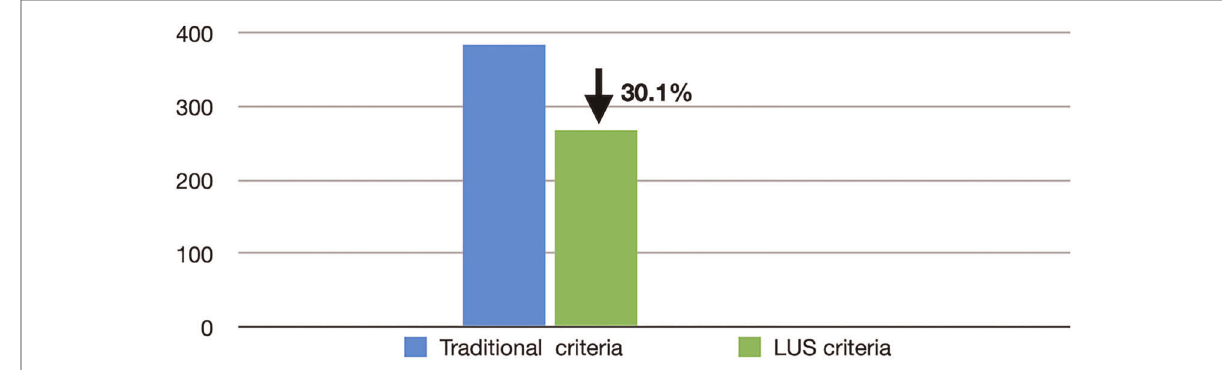
FIGURE 1 LUS decreases the misdiagnosis rate of RDS. Based on LUS diagnostic criteria, the misdiagnosis rate of RDS decreased 30.1% and correspondingly the application of exogenous PS decreased by the same proportion. LUS, lung ultrasound; RDS, respiratory distress syndrome; PS, pulmonary